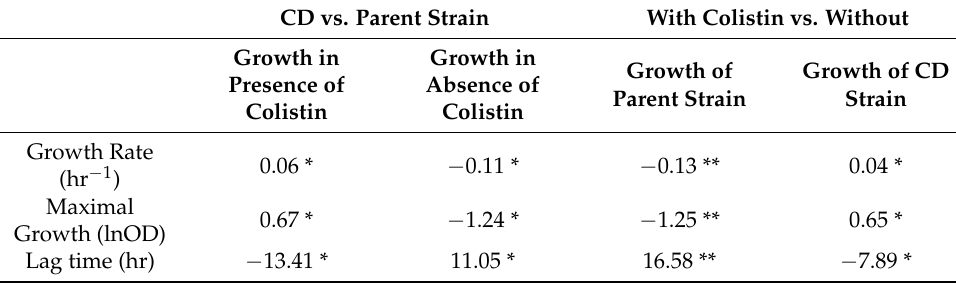
Table 1. Growth parameters of parent and CD strains with and without colistin. Presented are the average difference of three independent experiments. CD vs. Parent Strain With Colistin vs. Without Growth